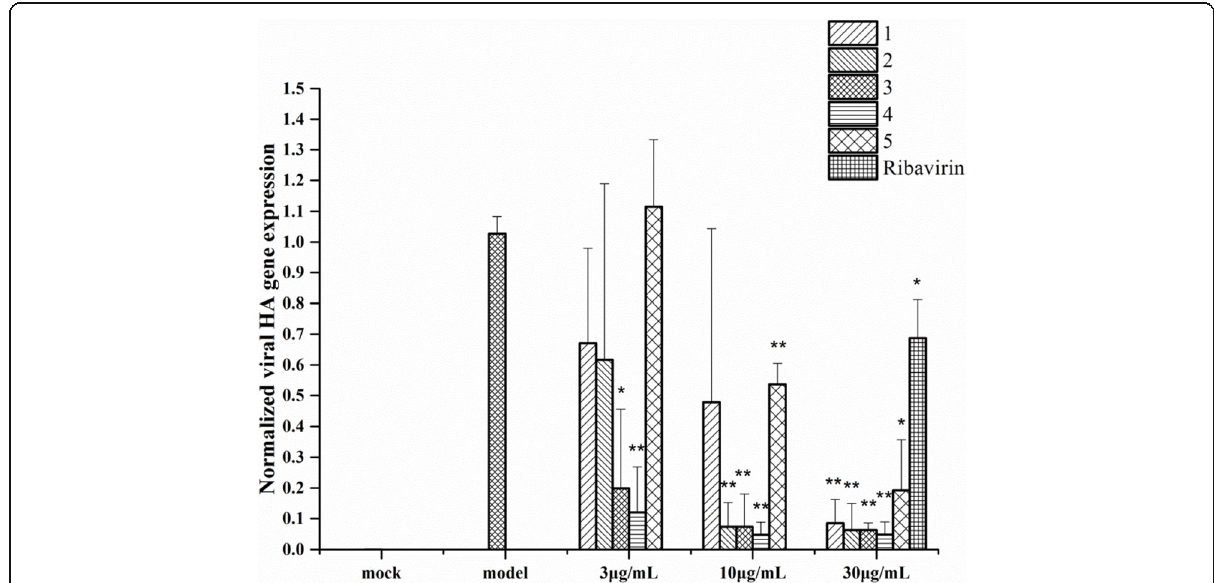
Fig. 1 Dose-dependent inhibitory effect of the extracts 1 – 5 on viral RNA synthesis. A549 cells were infected with 100 TCID 50 influenza H1N1 viruses and treated with different concentrations of the extracts 1 – 5 (3, 10 or 30 μ g/mL) and the DMSO (0.03%) for 5 h. The total RNA was extracted and followed by qPCR analysis. To quantify the changes in gene expression, the 2 - ΔΔ C(q) method was used to calculate relative changes which were normalized to the GAPDH gene and the untreated control (model group, which was set to 1). Value calculated as Mean ± SD of three independent tests, with * p < 0.05 and ** p < 0.001,